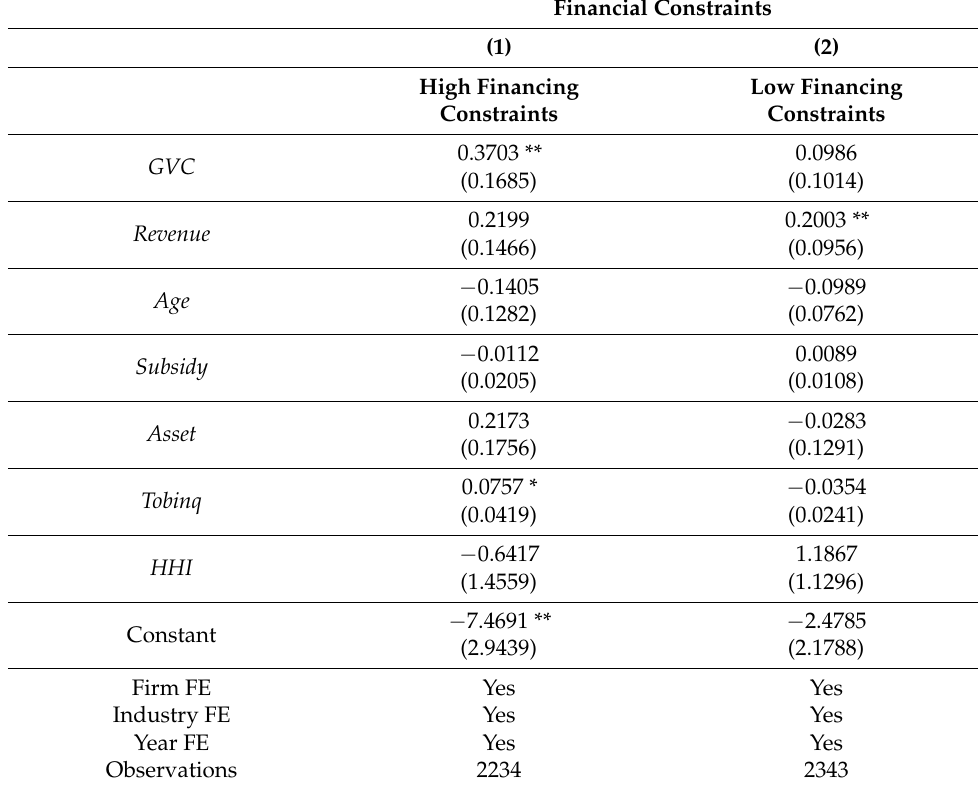
Table 4. Firm heterogeneity analysis: Financial